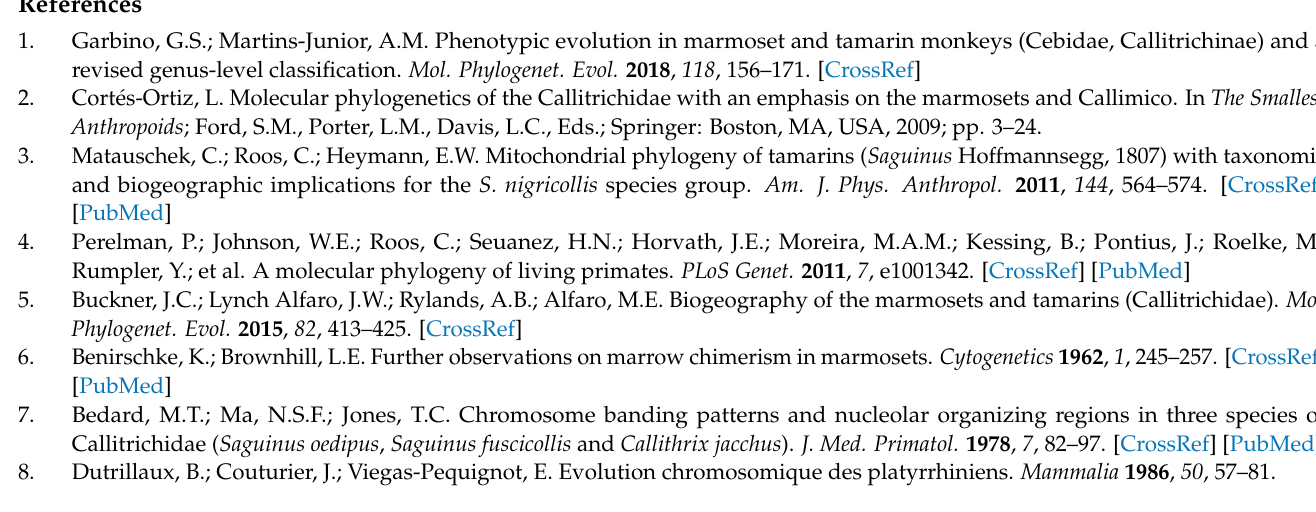
stars label NOR-bearing chromosomes, the hash sign marks chromosomes with telomeric signal amplification. Figure S3. Leontopithecus rosalia metaphases in DAPI inverted (a), in DAPI (b), rDNA probe mapping (c), telomeric probe mapping (d); the reconstructed karyotype of L. rosalia after sequential CMA3/ DAPI, DAPI inverted, FISH with Telomeric and rDNA probes. The red stars label NOR-bearing chromosomes, the hash sign marks chromosomes with telomeric signal amplification. Figure S4. Saguinus mystax metaphases in DAPI inverted (a), in DAPI (b), rDNA probe mapping (c), telomeric probe mapping (d); the reconstructed karyotype of S. mystax after sequential CMA3/DAPI, DAPI inverted, FISH with telomeric and rDNA probes, and C banding obtained after chromosome denaturation in formamide (f). The red stars label NOR-bearing chromosomes, the hash sign marks chromosomes with telomeric signal amplification. Figure S5. Leontocebus fuscicollis metaphases in DAPI inverted (a), DAPI (b), rDNA probe mapping (c), telomeric probe mapping (d). The karyotype of L. fuscicollis after sequential CMA3/DAPI staining, FISH with telomeric and rDNA probes, and C banding obtained after chromosome denaturation in formamide. The red stars label NOR-bearing chromosomes, the hash sign marks chromosomes with telomeric signal